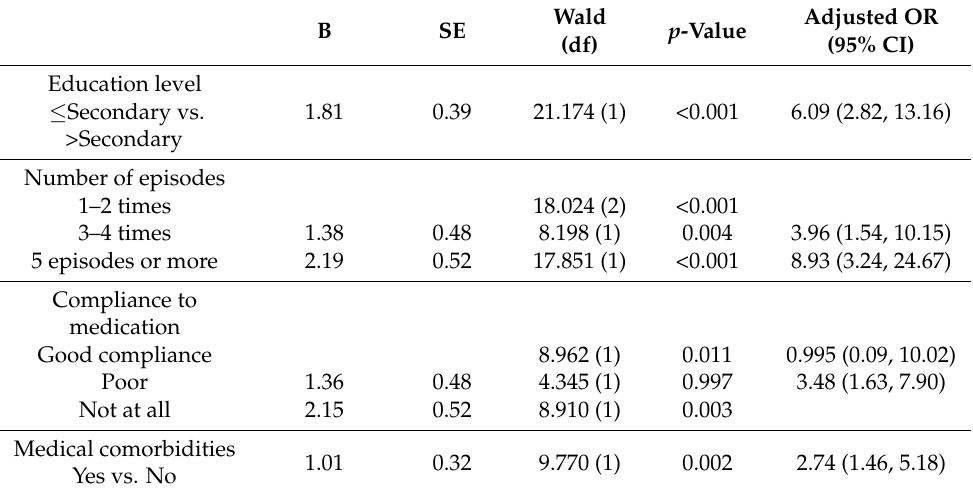
Table 4. Multiple Logistic Regression Analysis with Cognitive Decline as Dependent